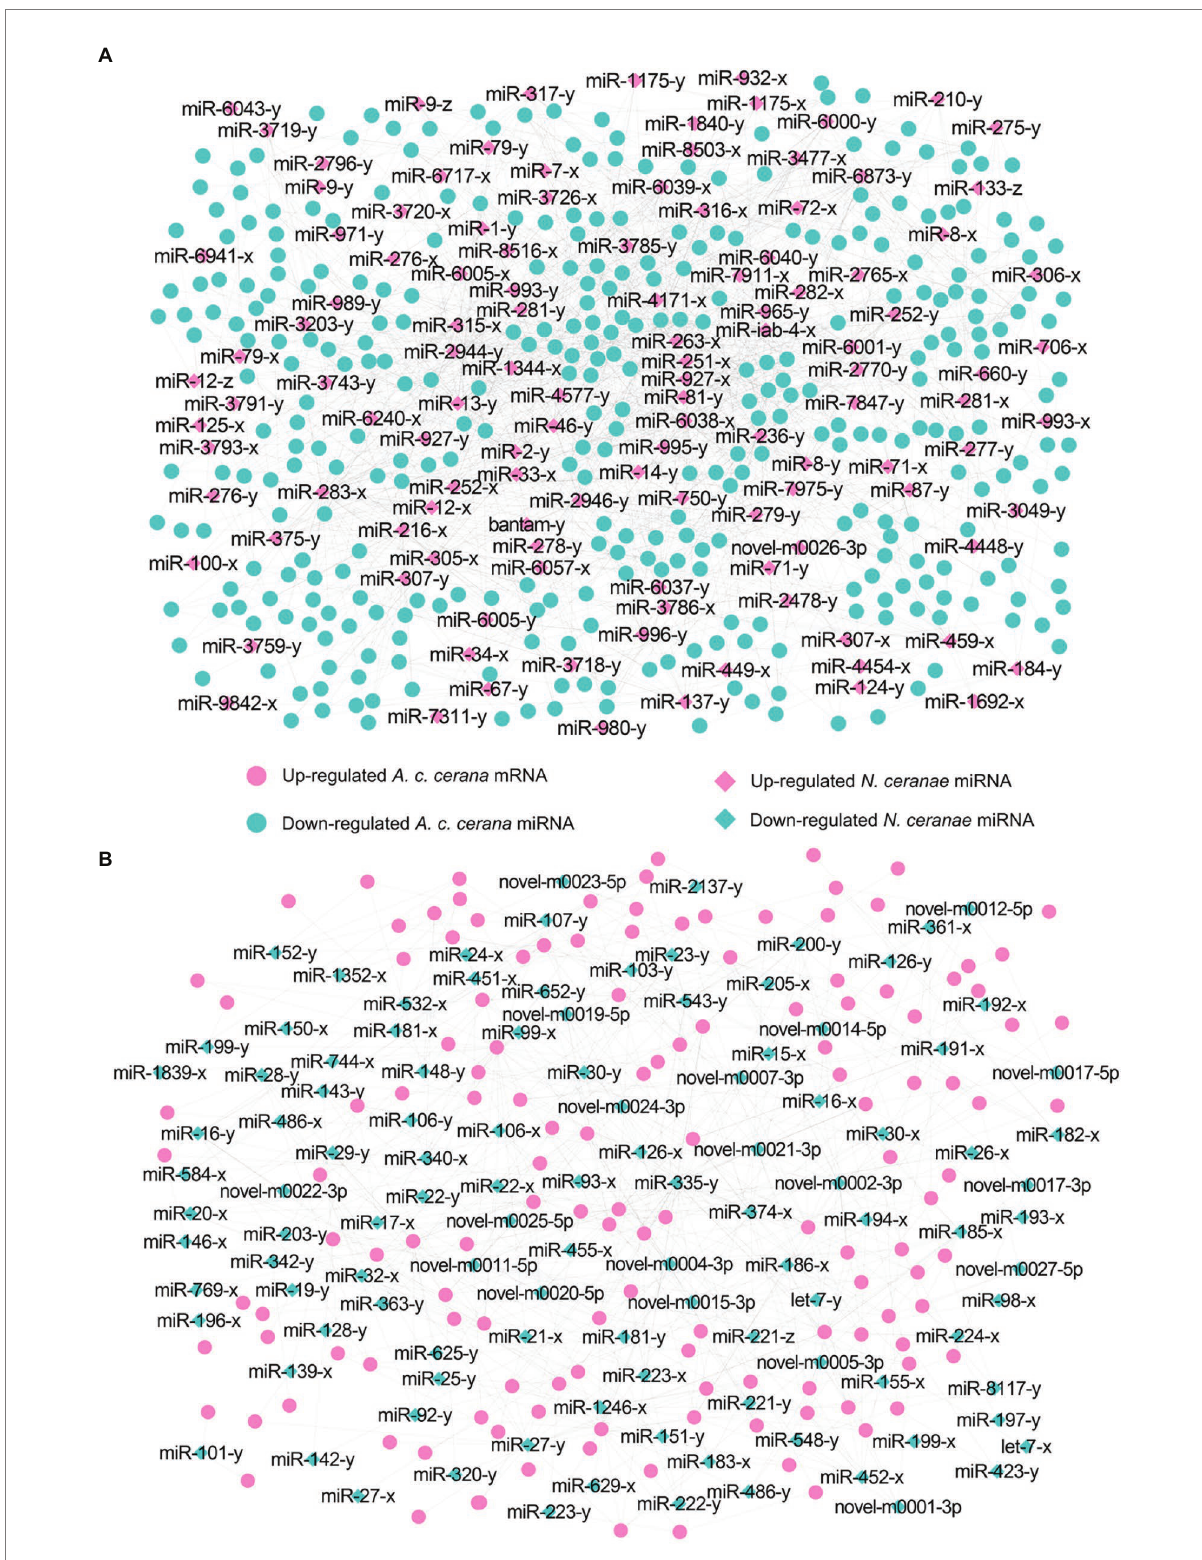
FIGURE 5 Regulatory networks of N. ceranae DEmiRNAs and target DEmRNAs in A. c. cerana workers’ midguts at 7 dpi. (A) Regulatory network between up-regulated miRNAs in microsporidian and down-regulated mRNAs in host. (B) Regulatory network down-regulated miRNAs in microsporidian and up-regulated mRNAs in